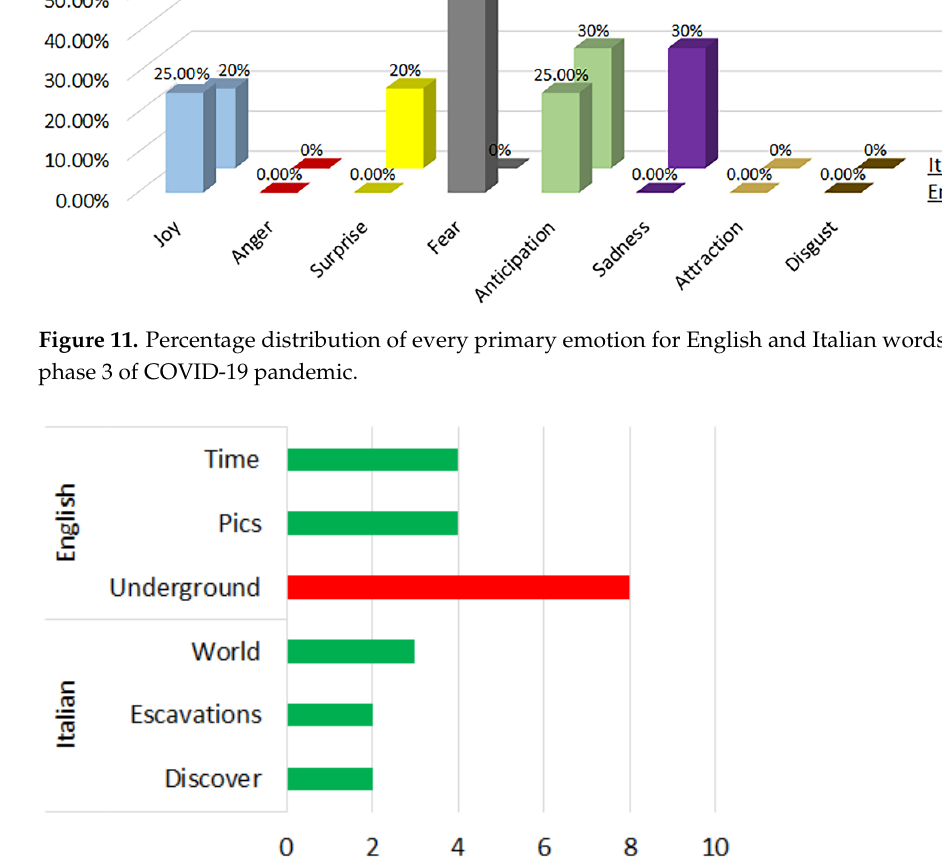
Figure 12. Rating of the most-cited words in English and Italian during phase 3 of COVID-19 pandemic (green is positive, red is negative). Step 1 was repeated for each of the individual phases indicated in Figure